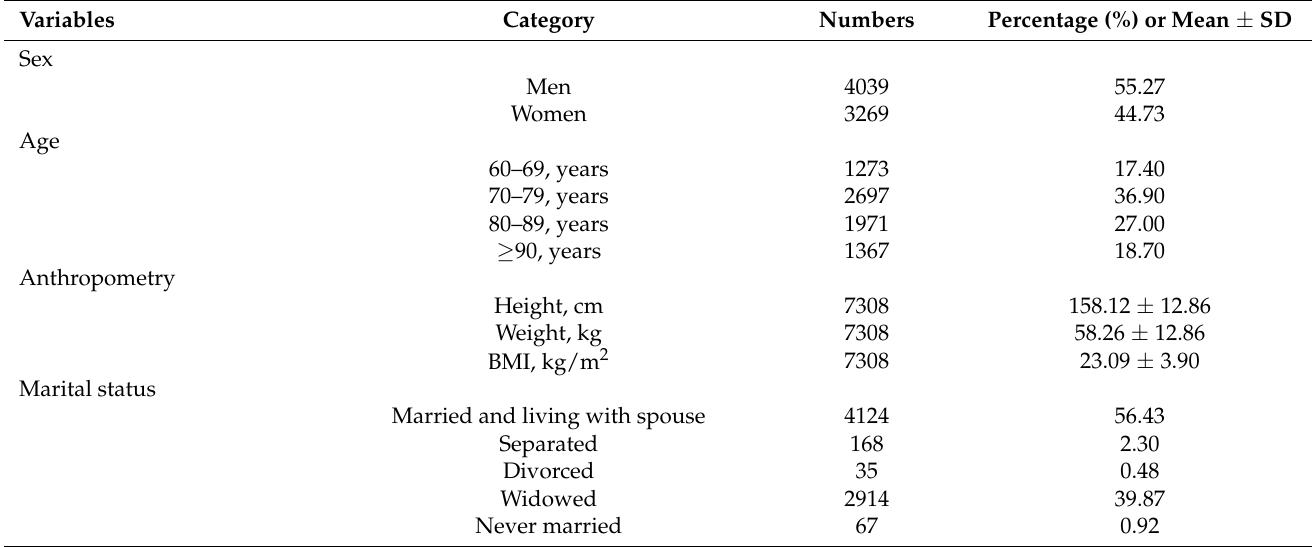
Table 1. The demographic characteristics and MMSE scores of involved participants ( n =